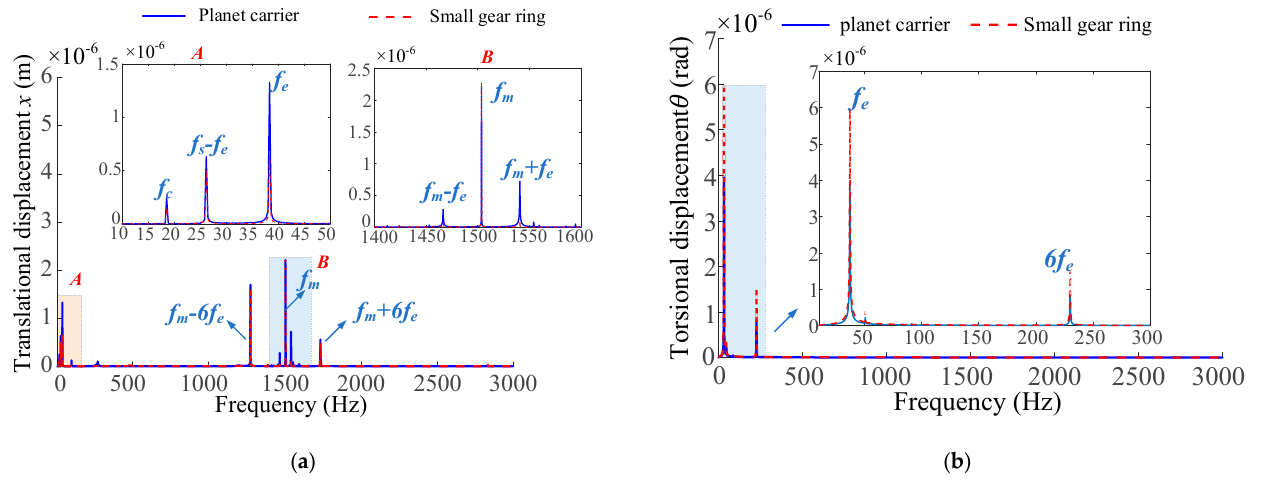
Figure 18. Frequency of vibration displacement of planetary carrier and small gear ring: ( a ) Spectrum of translational displacement; ( b ) Spectrum of torsional displacement.